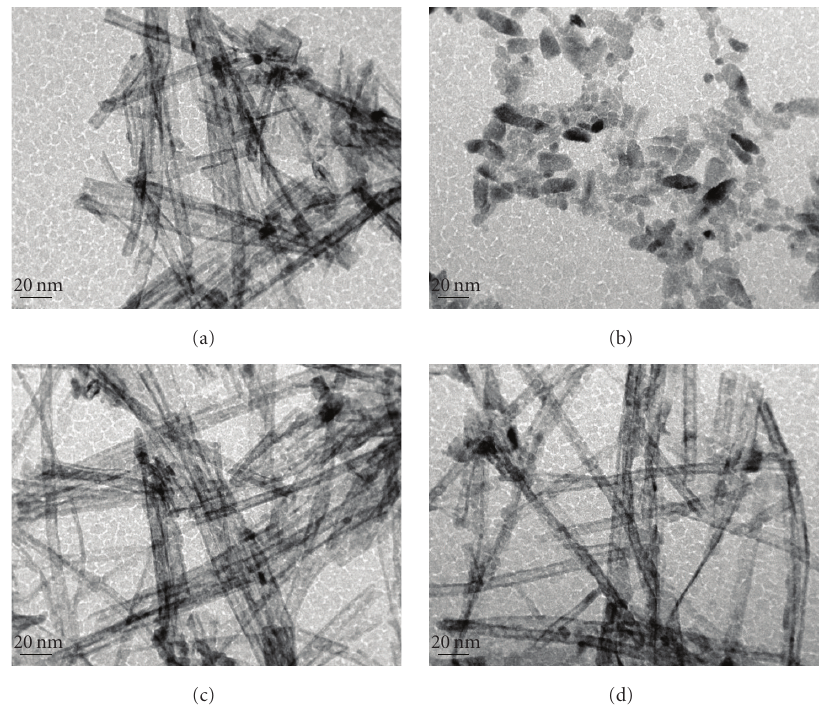
Figure 7: TEM photos for some samples in Figure 6; (a) 400 ◦ C for 30 min in H 2 , (b) 500 ◦ C for 10min in H 2 , (c) 475 ◦ C for 30 min in air and (d) 500 ◦ C for 10min in air